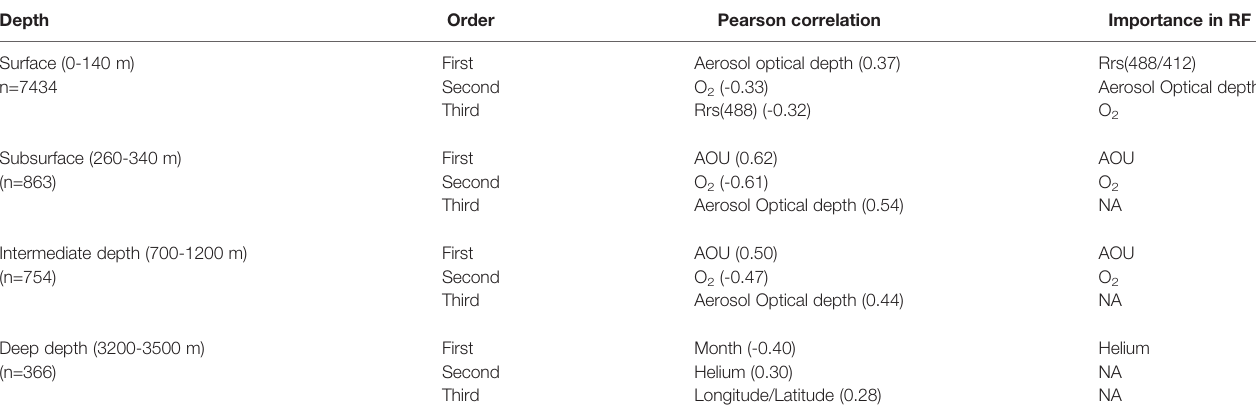
TABLE 2 | Most important environmental predictors based on Pearson correlation and importance in the construction of the random forest (RF) algorithm (only top three are shown; the comprehensive results for all the predictors are provided in Table S1 and Figure S2 ). Depth Order Pearson correlation Importance in